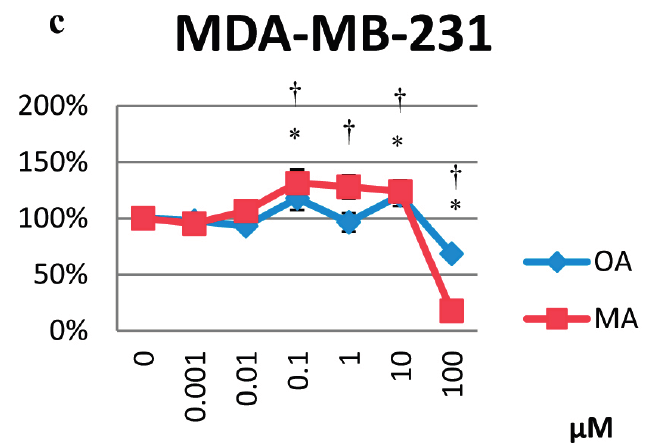
Figure 1. Cytotoxicity of OA and MA from 0.001 µM to 100 µM in MCF10A cells ( a ), MCF7 cells ( b ) and MDA-MB-231 cells ( c ) at 24 h. Values represent the mean ± SEM